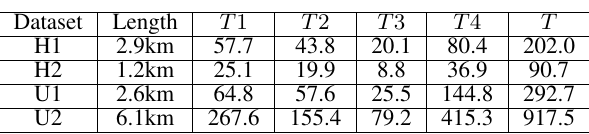
Table 4. Evaluation of the proposed method’s vectorization accuracy (unit:cm, ’H’:Highway, ’U’:Urban road)